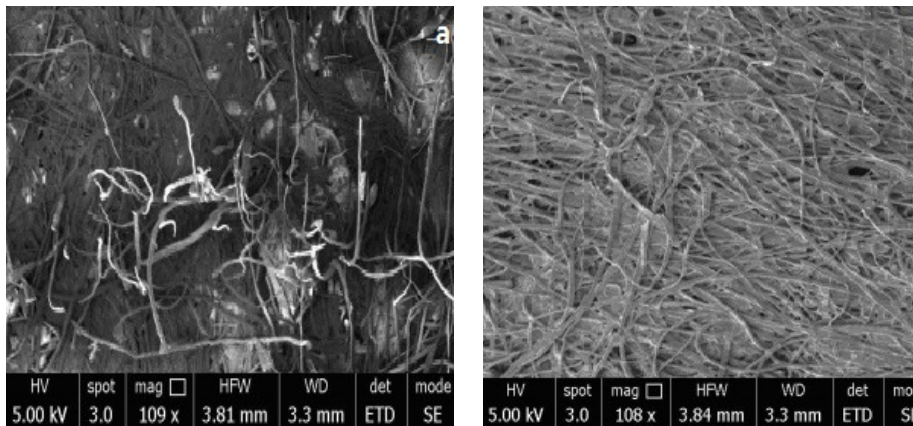
Figure 9. SEM images of Xuan paper treated with polyurethane liquid before ( a ) and after ( b ).